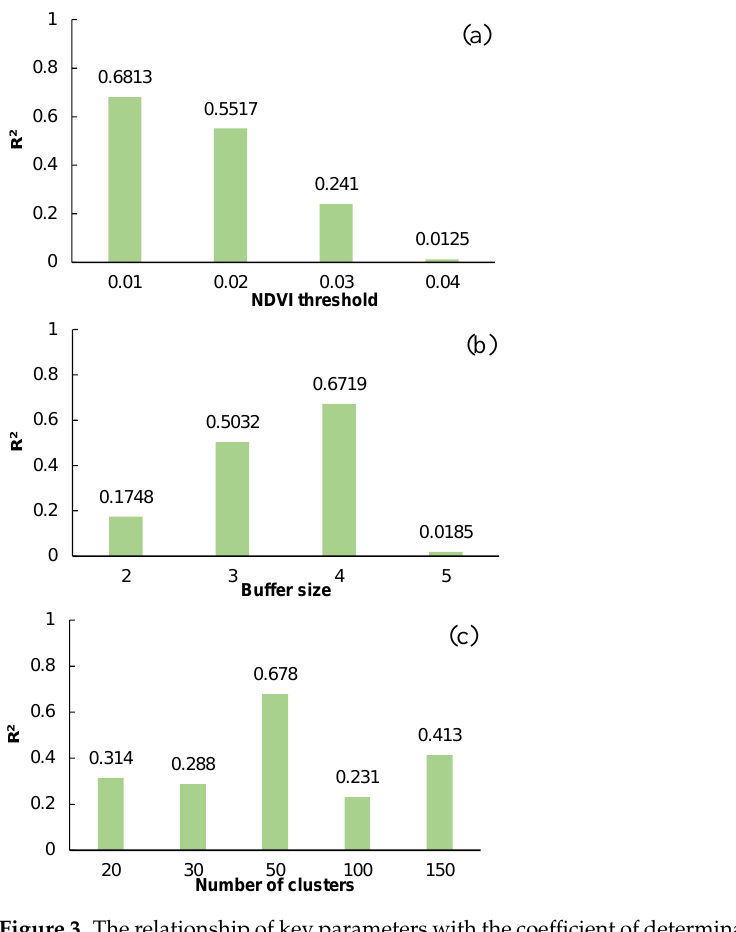
y = 0.8696x + 0.1001 R² = 0.6827